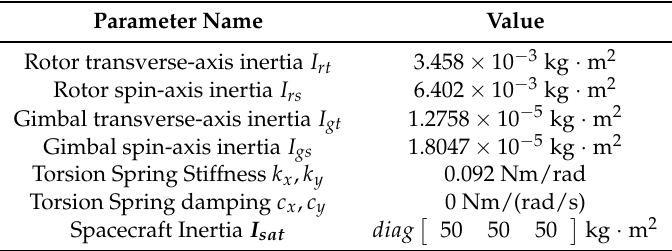
Table 1. Gyrowheel and Spacecraft Design Parameter in Simulation